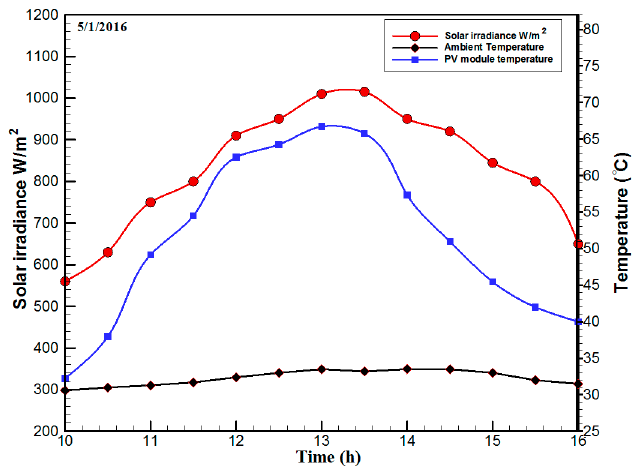
Figure 5. The hourly variation of solar irradiance intensity, PV temperature and ambient temperature of Universiti Kebangsaan Malaysia (UKM), Bangi on 5 January 2016.